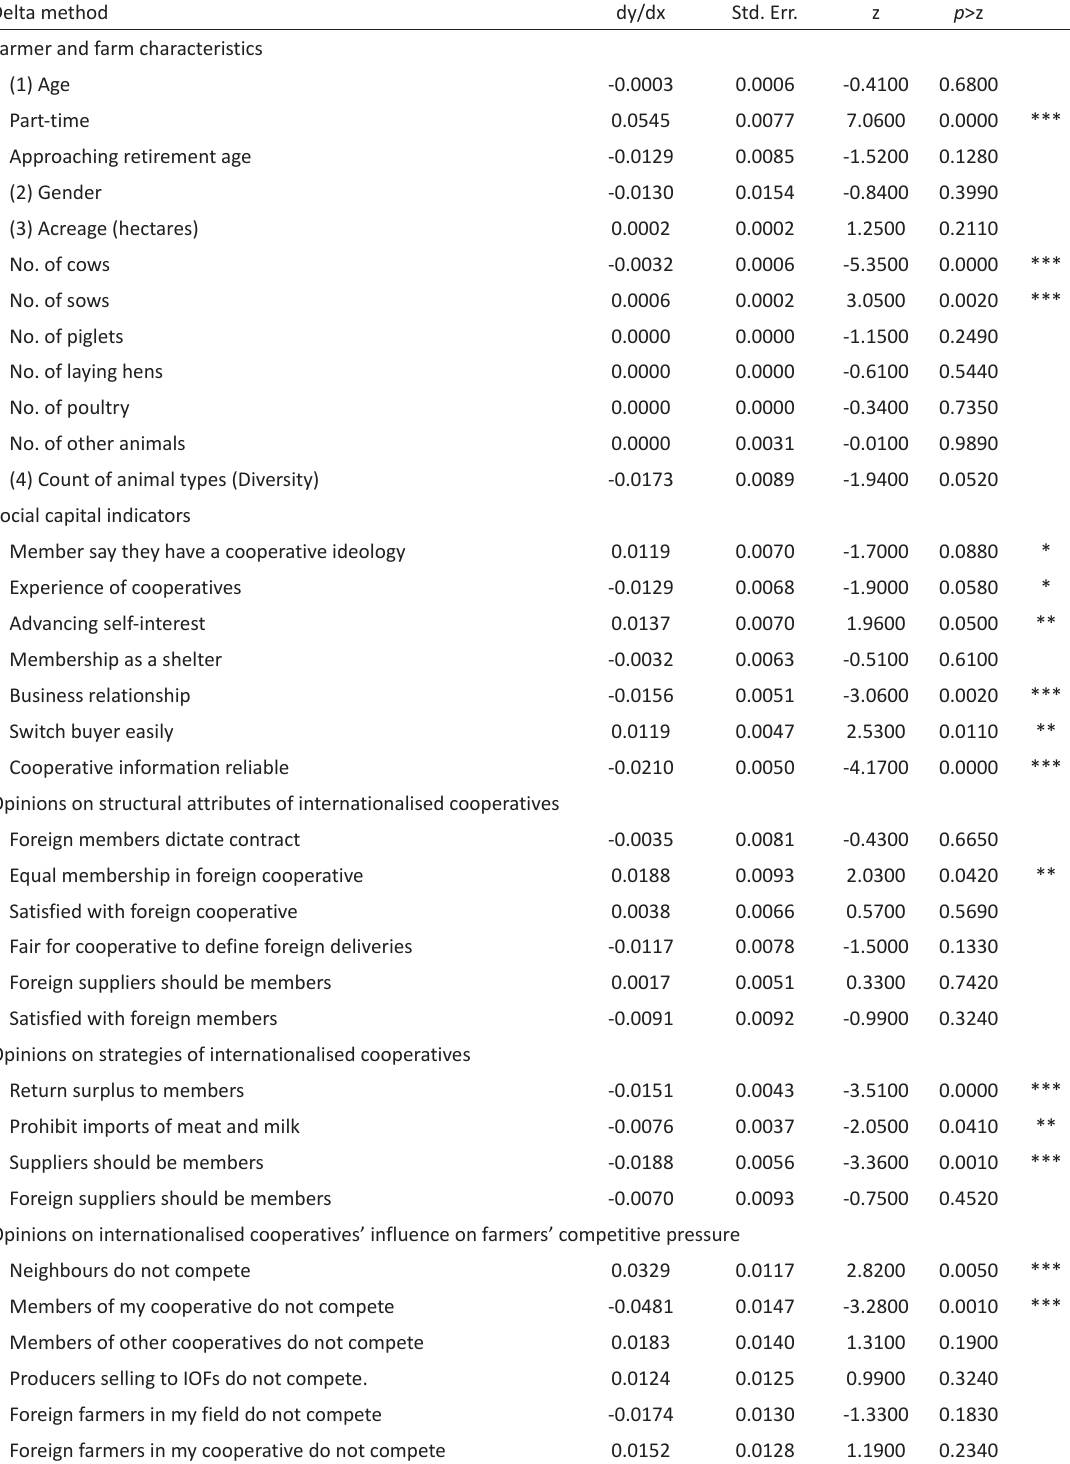
Table 1: Marginal effects (dy/dx) according to the ordered logit model (model 2: Dependent variable = ‘Number of cooperatives that the respondent supplies’ Delta